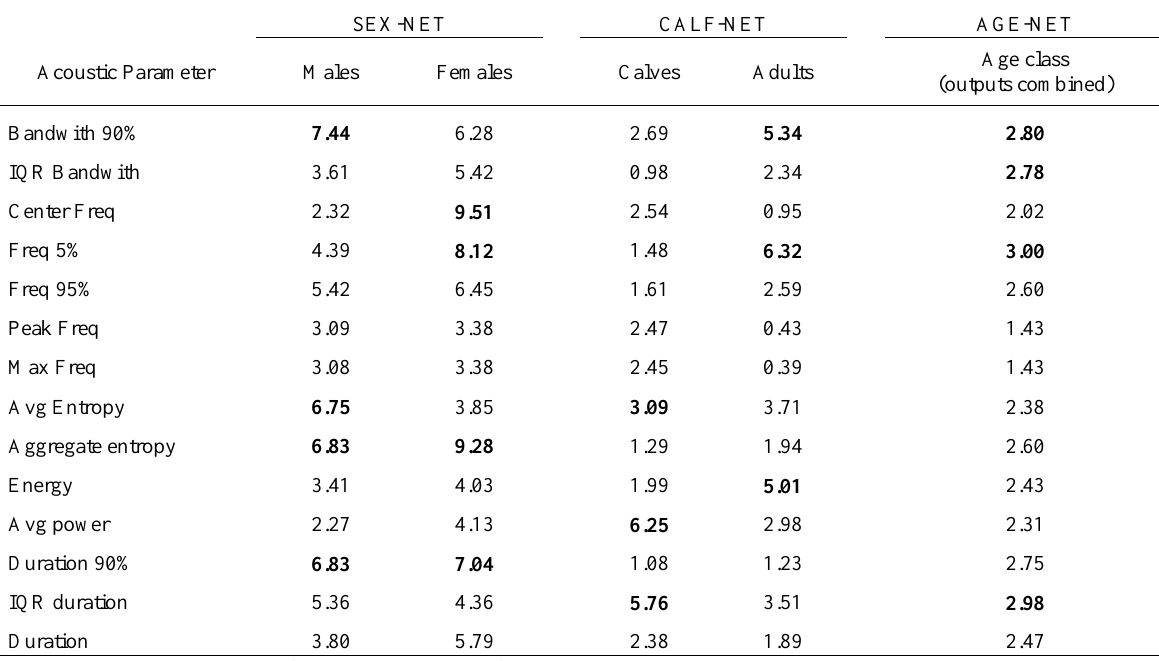
Age class (outputs combined)